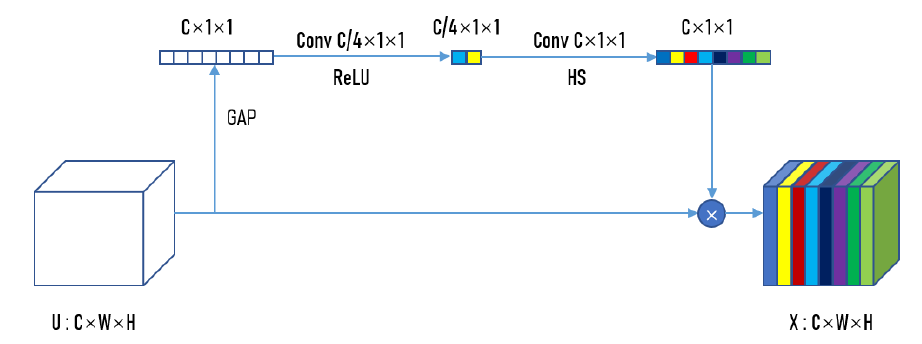
Figure 5. The principle of the channel attention mechanism.